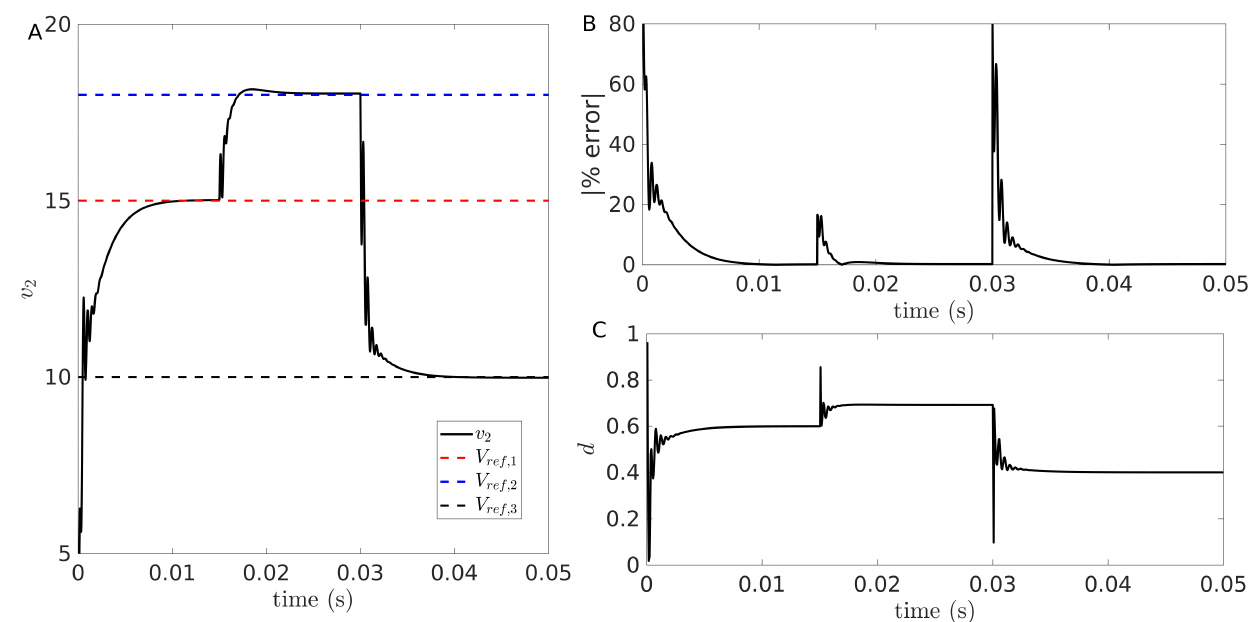
Figure 10. Time trace of the ramp controlled sZETA converter under mixed perturbations of the input: ( A ) voltage trace; ( B ); error percentage; ( C ) duty cycle. In all panels, the following transitions were defined: for t < 15 ms, ( R , V in , V ref ,1 ) = ( 100 Ω ,10 V,15 V ) ; for 15 ms ≤ t < 30 ms, ( R , V ( 200 Ω ,15 V,10 V )